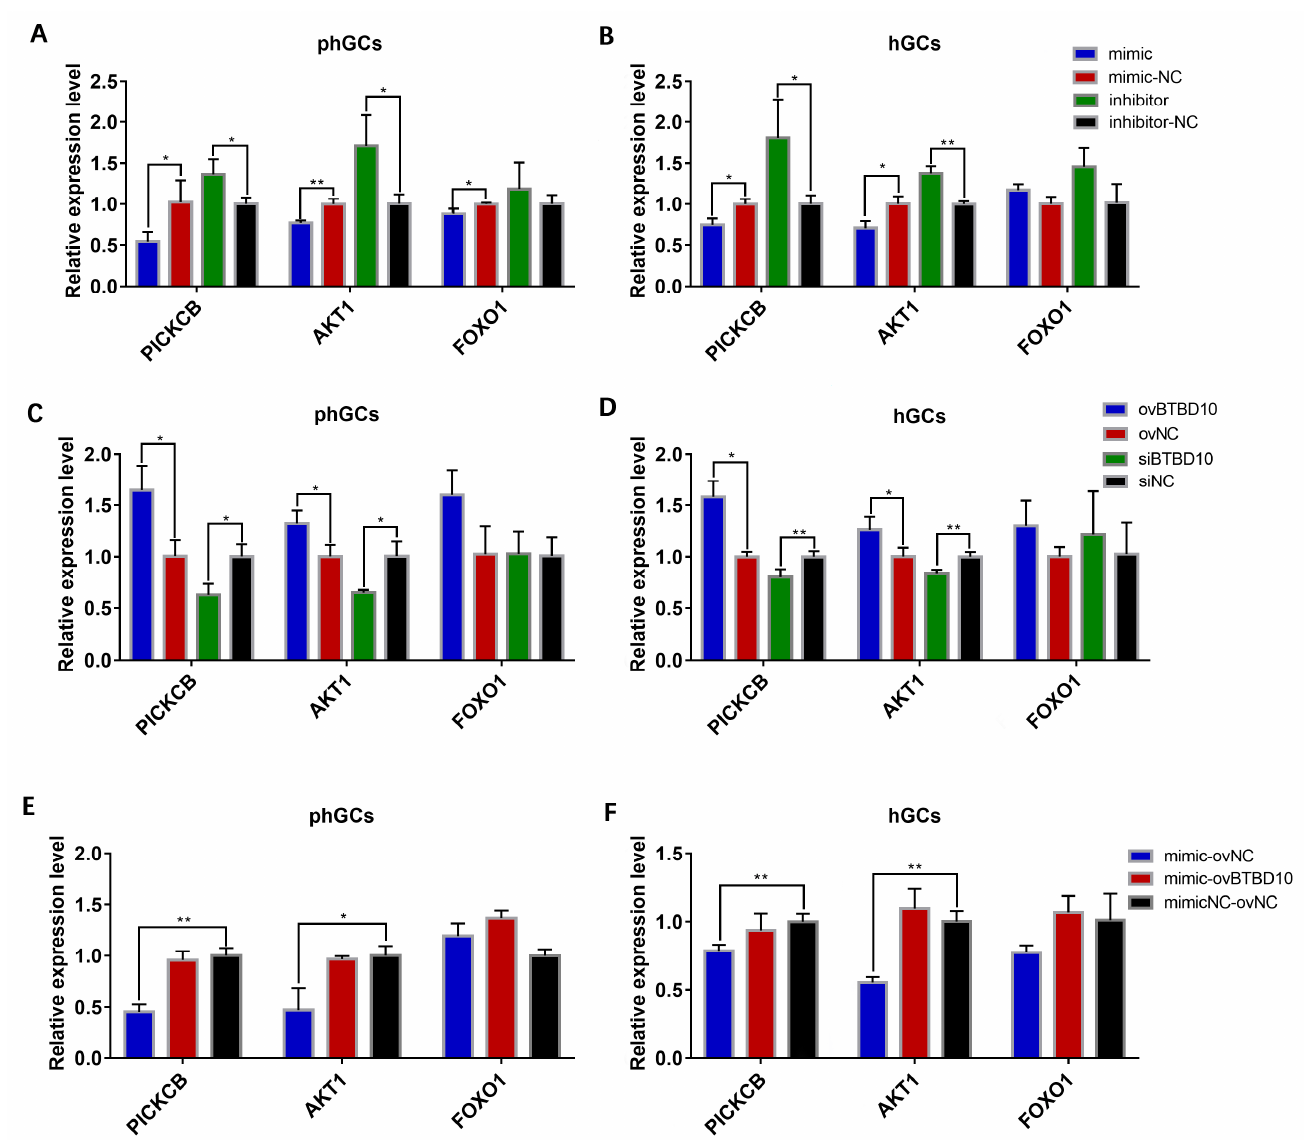
Figure 9. The e ff ect of miR-202-5p and BTBD10 on the expression of PIK3CB / AKT1/FOXO1 pathway. The e ff ect of miR-202-5p mimic/inhibitor on the expression of PIK3CB / AKT1/FOXO1 in ph GCs ( A ) and hGCs ( B ) (n = 3); the e ff ects of ovBTBD10 and siBTBD0 on the expression of PIK3CB / AKT1/FOXO1 in ph GCs ( C ) and hGCs ( D ) (n = 3); the e ff ect of miR-202-5p mimic and ovBTBD10 co-transfection on PIK3CB / AKT1/FOXO1 expression in phGCs ( E ) and hGCs ( F ) (n = 3). Data are means ± SD of technical replicates. * p < 0.05, ** p < 0.01.